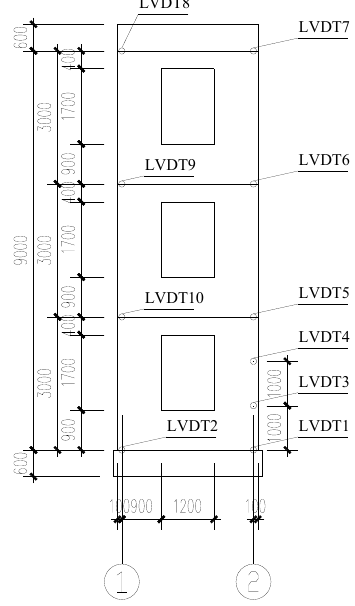
Figure 5. Arrangement of displacement measuring points.